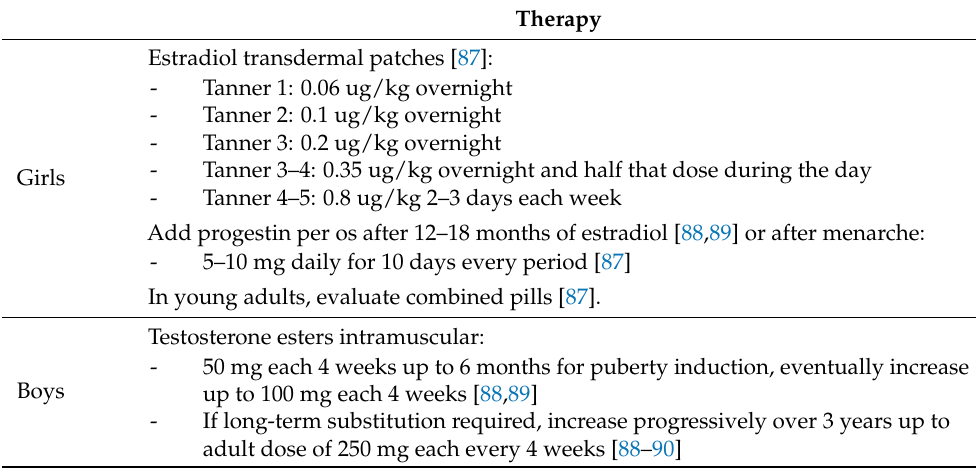
Table 3. Puberty induction and substitution therapy in case of gonadal dysfunction